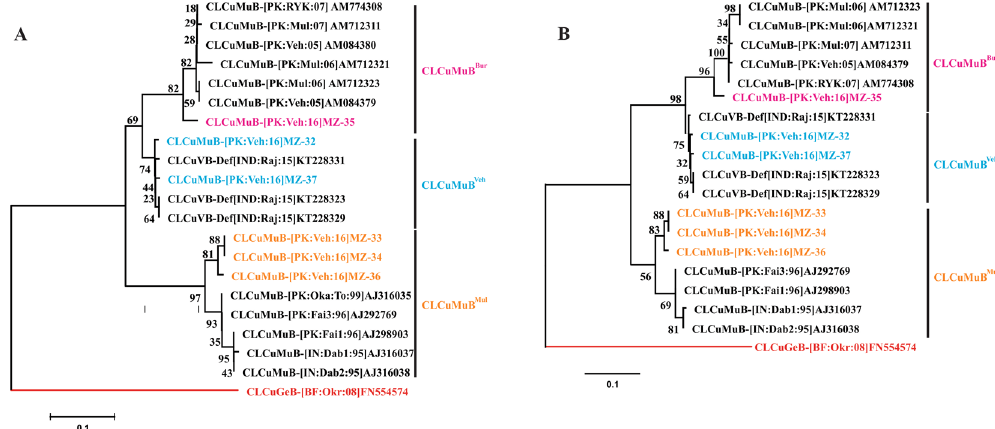
Figure 5. Phylogenetic tree of full length and SCR of betasatellite clones from cotton. (A) Phylogenetic tree of full length betasatellites. Cotton leaf curl Gezira betasatellite (CLCuGeB) was taken as outgroup. The tree is supported by 1000 bootstrap value. ( B) Phylogenetic tree of SCR region of betasatellites. Three types of betasatellites were identified from both full and SCR alignments.